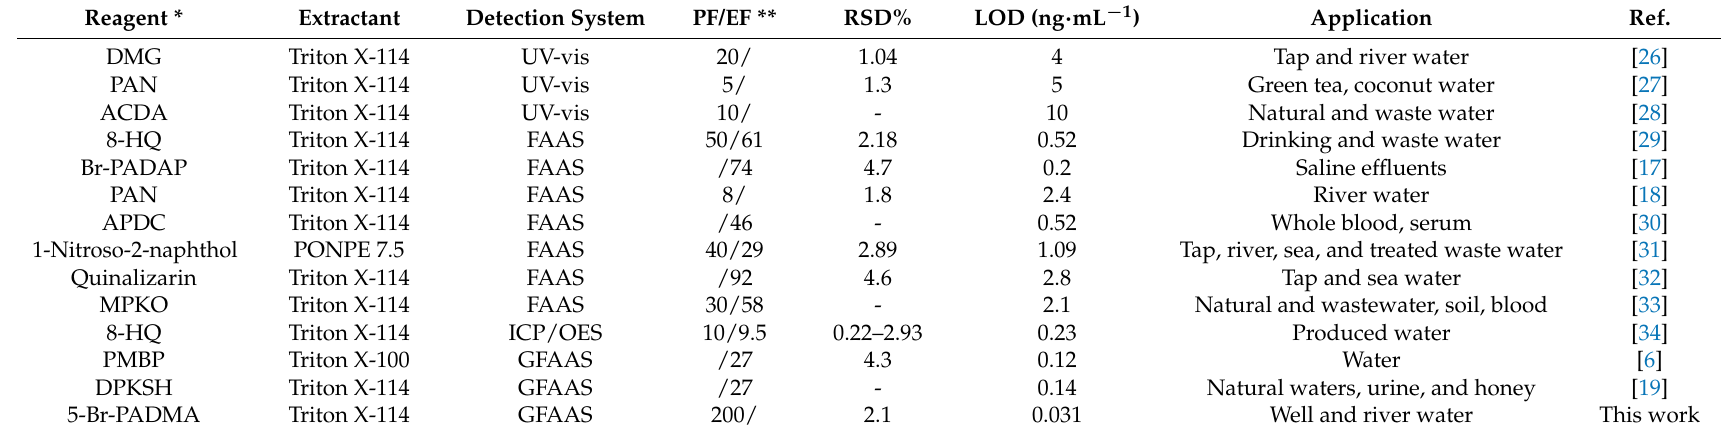
Table 3. Comparison of the proposed method with previously reported methods using cloud point extraction (CPE) prior to nickel determination. GFAAS—graphite furnace atomic absorption spectrometry; ICP—inductively coupled plasma; RSD—relative standard